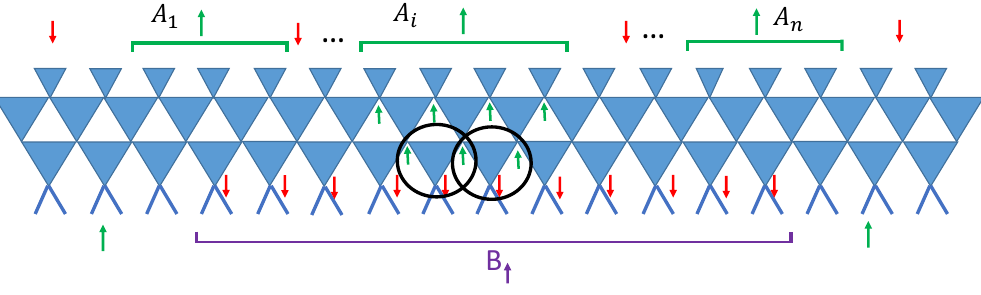
Figure 23 . A case with t < | A i | / 2 for some A i . Any configuration in the partition function at such times contributes 0 due to the circled